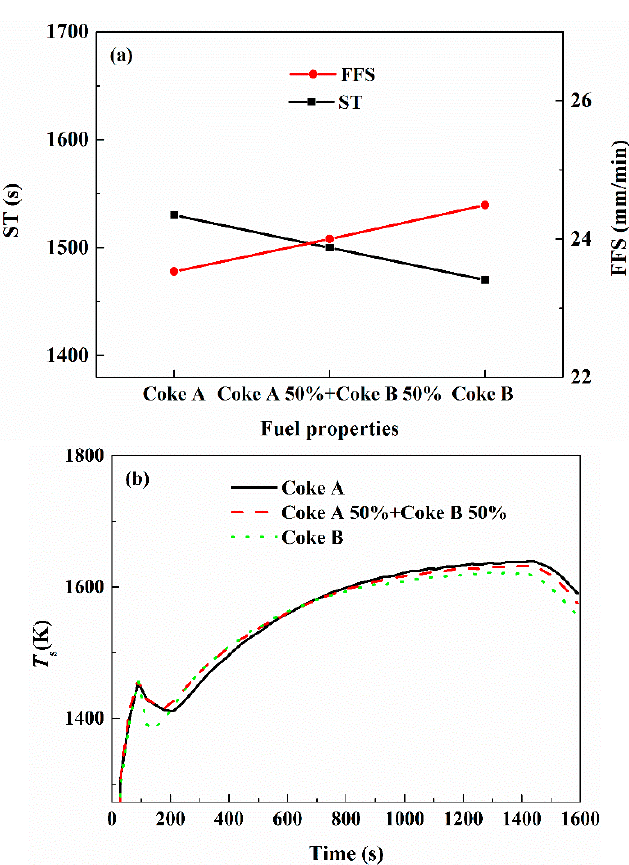
Figure 5. FFS and Sintering Time (ST) ( a ) and MaxT ( b ) with different fuel types.